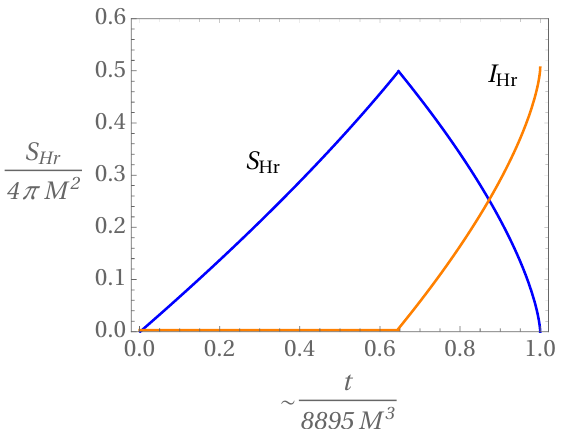
Figure 3. Time evolution of, the Von Neumann entropy ( S Hr ) (according to Page curve [44,46]), and the information ( I Hr ) for the Hawking